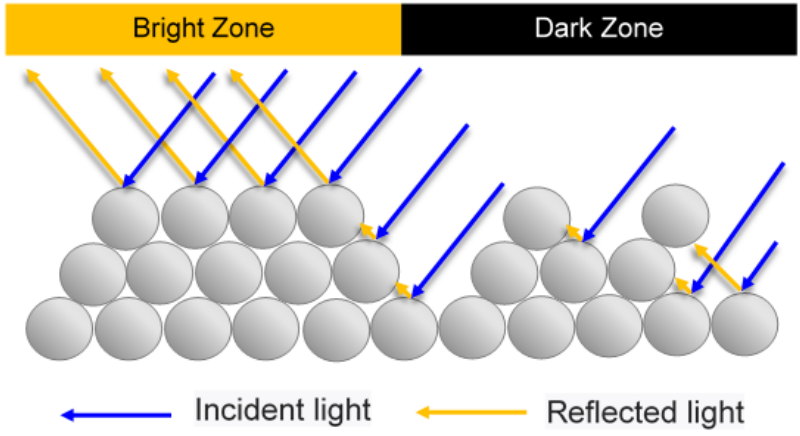
Figure 3. Schematic illustration showing formation of black lines under effects of different powder particle concentrations.